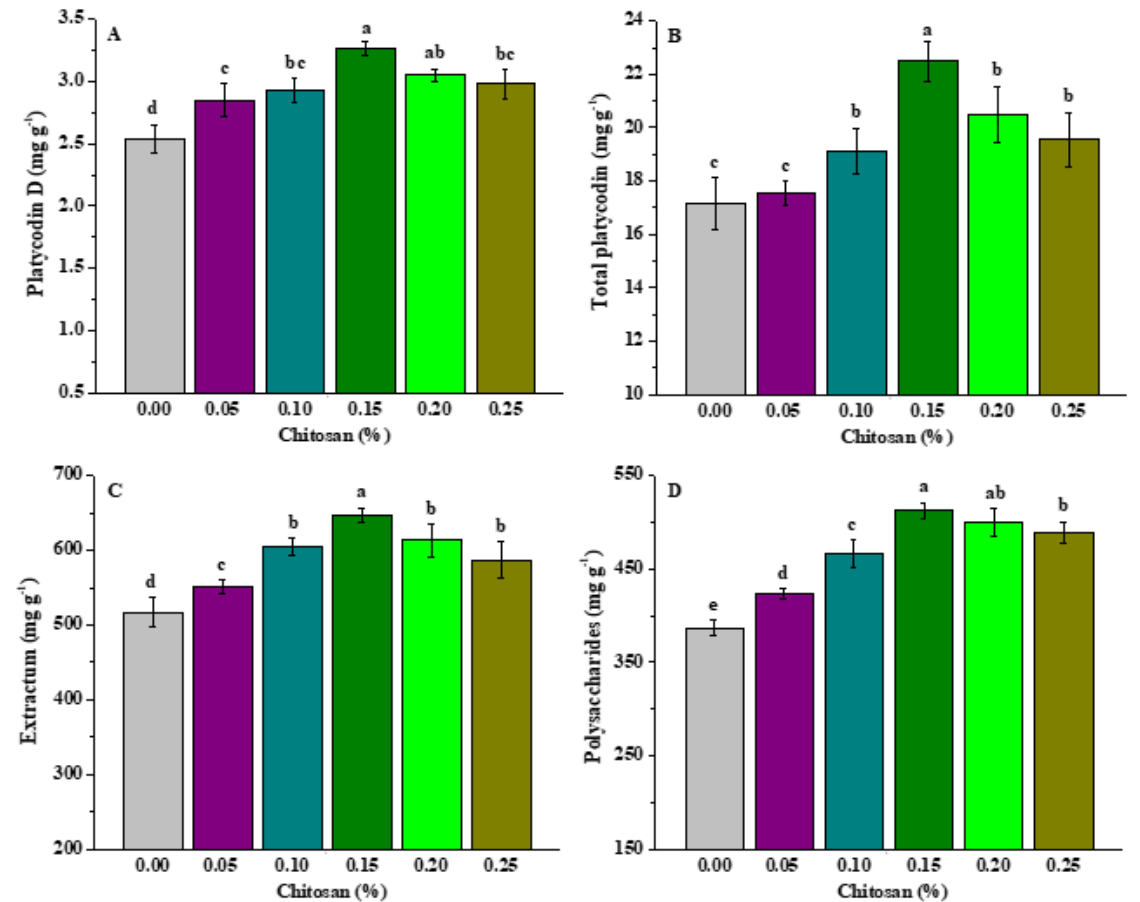
Figure 4. Influences of chitosan soaking on platycodin D ( A ), total platycodin ( B ), extractum ( C ), and polysaccharides ( D ) of P. grandiflorus . The SD of three replicates was indicated by error bar. A one-way analysis of variance (ANOVA) followed by Duncan’s test was used, and the significant differences at a 5% level ( p < 0.05) in the six treatments are represented by different letters.